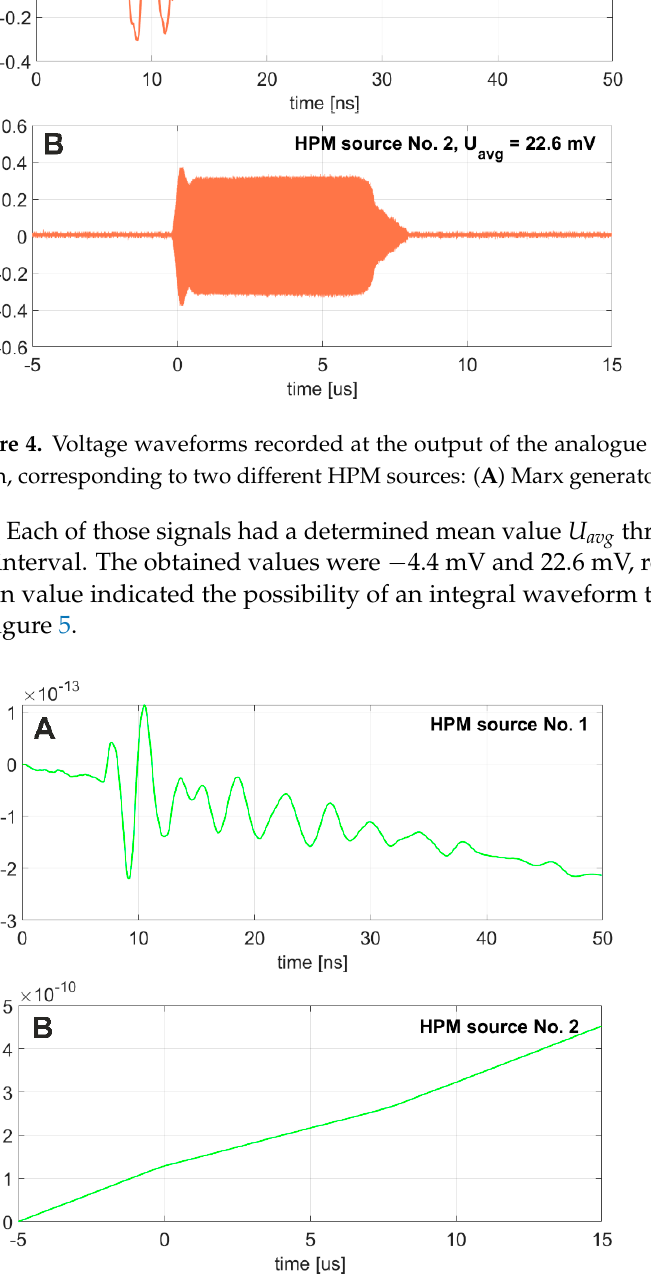
Figure 5. The waveforms of signal integrals from Figure 4, obtained with the Tustin method: ( A ) Marx generator; ( B ) magnetron generator.